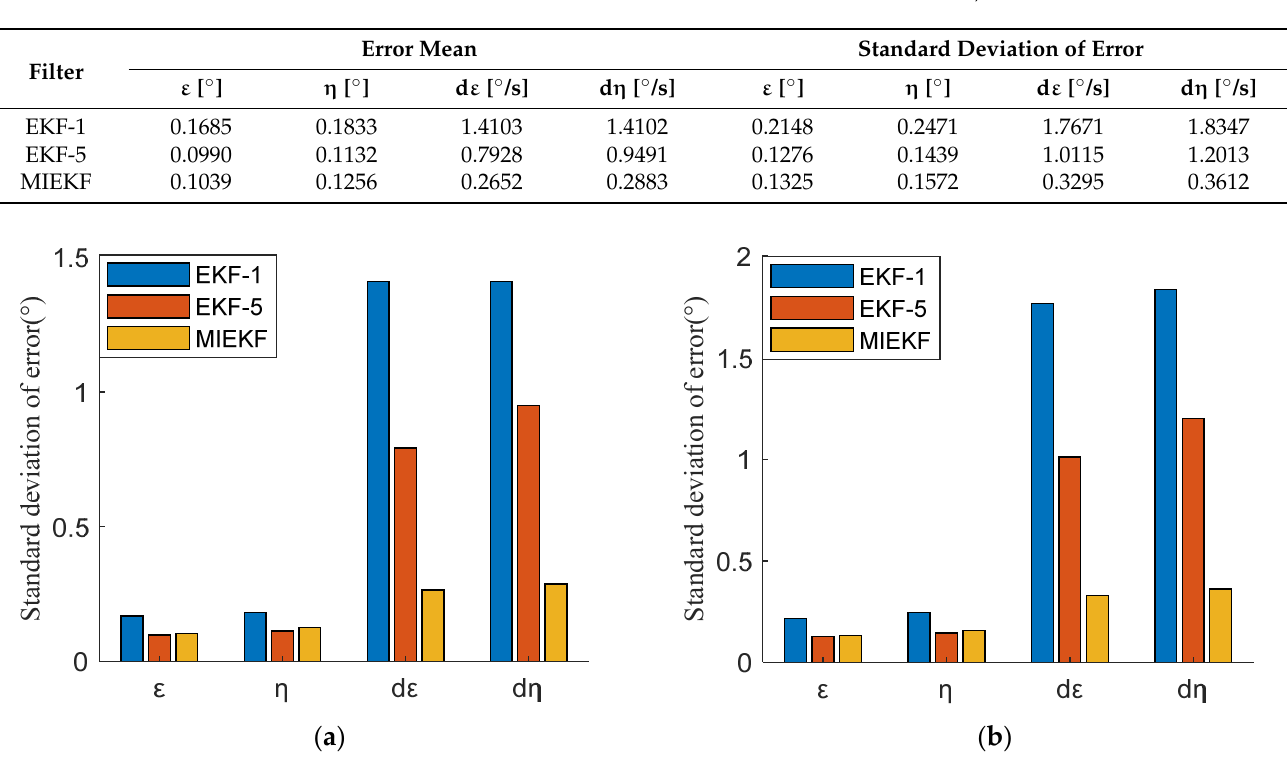
Table 3. The error means and standard deviations of error of EKF-1, EKF-5 and MIEKF.